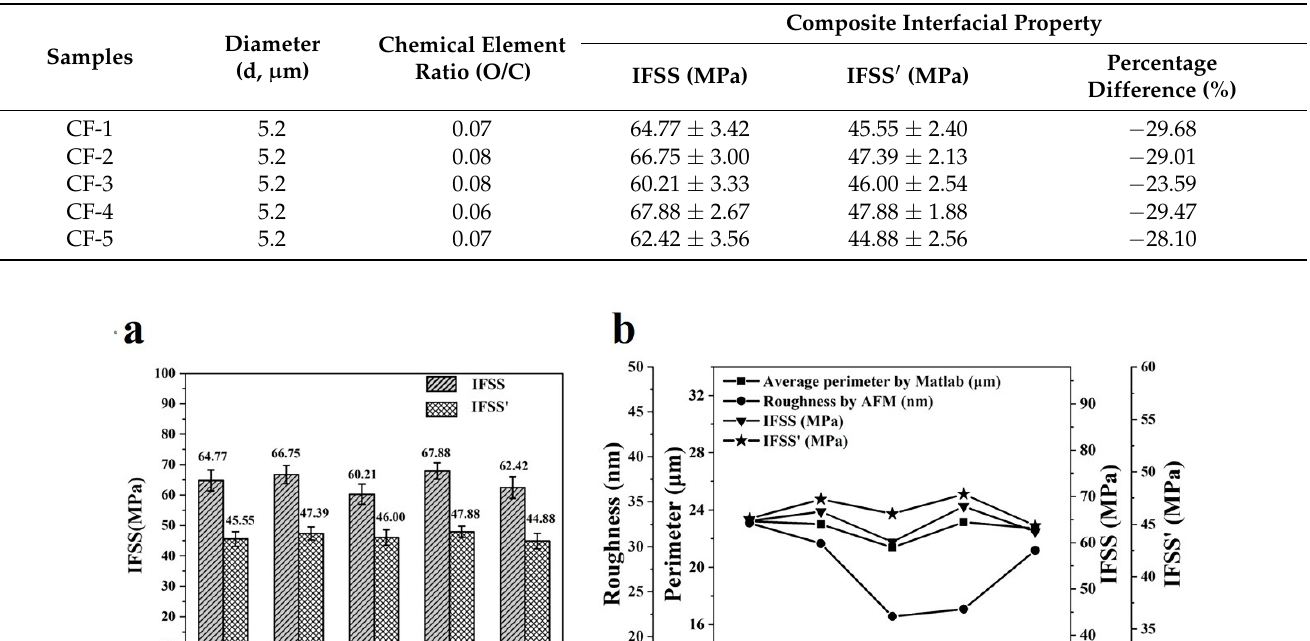
Table 3. Surface physicochemical properties and composite interfacial property of CFs.